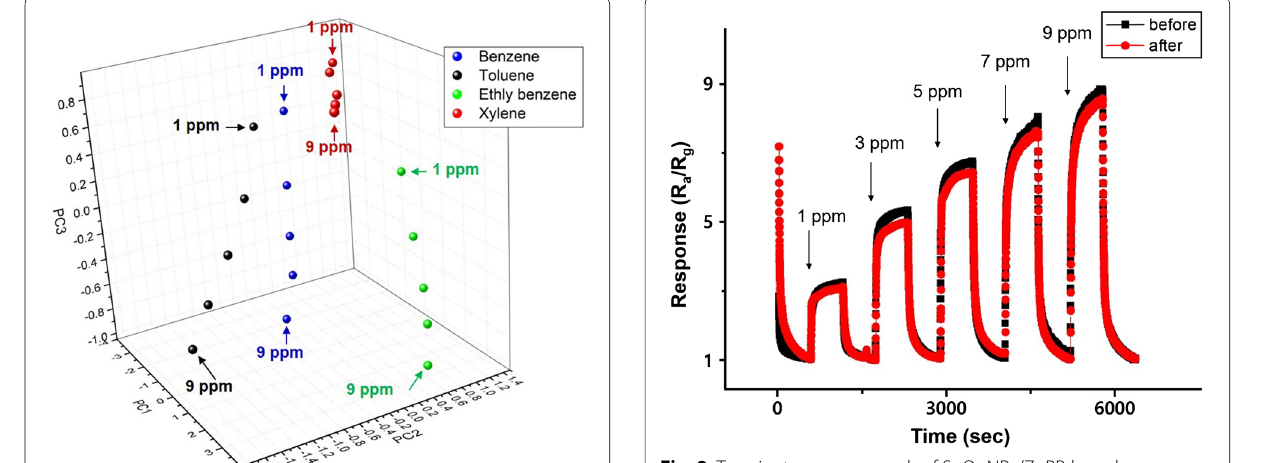
Fig. 8 Transient response graph of SnO 2 NPs/ZnPP-based sensor before and after impact test at toluene environment. The sensor was dropped five times from a height of 150